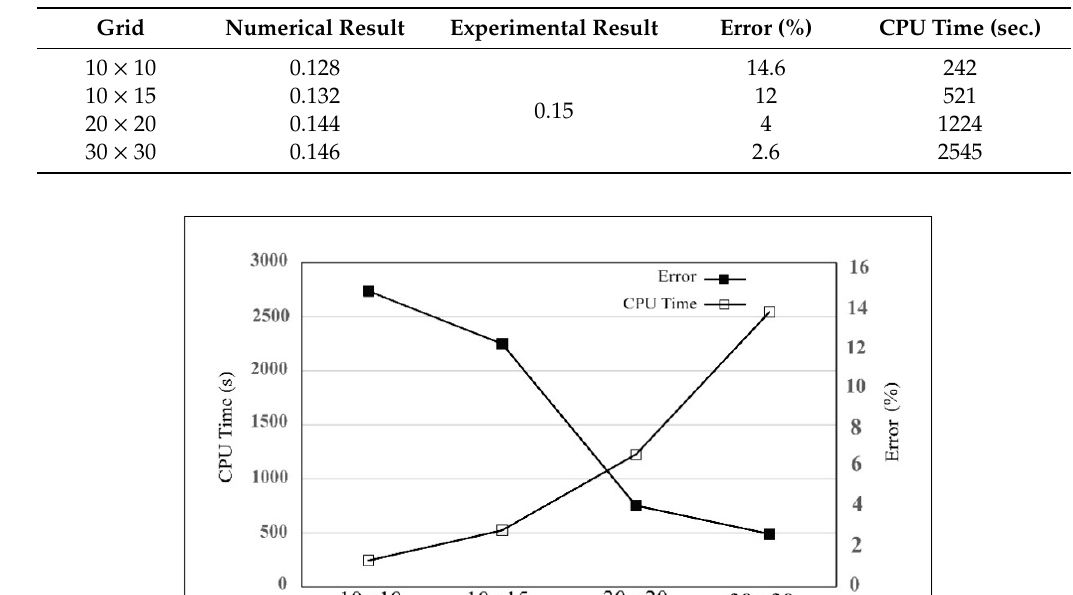
Table 3. CPU Time and error for different grids (J = 0.833 ) .